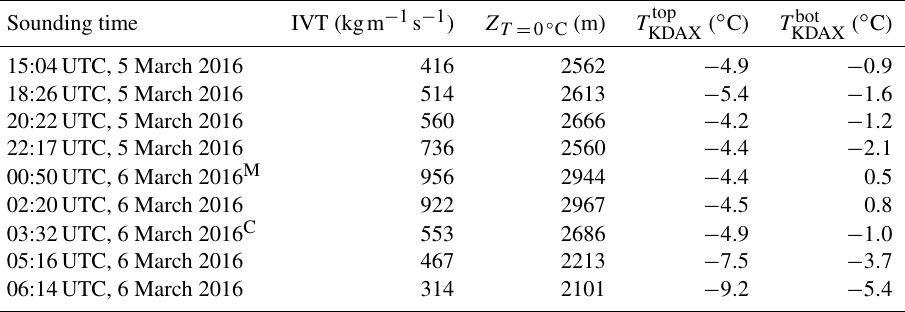
Table 2. Balloon-borne soundings launched from BBY and their metadata: integrated vapor transport (IVT), height of freezing isotherm, and top and bottom temperatures of the KDAX radar retrieval layer (see Sect. 3c). Superscripts M,C denote maximum AR strength and transit of cold front,